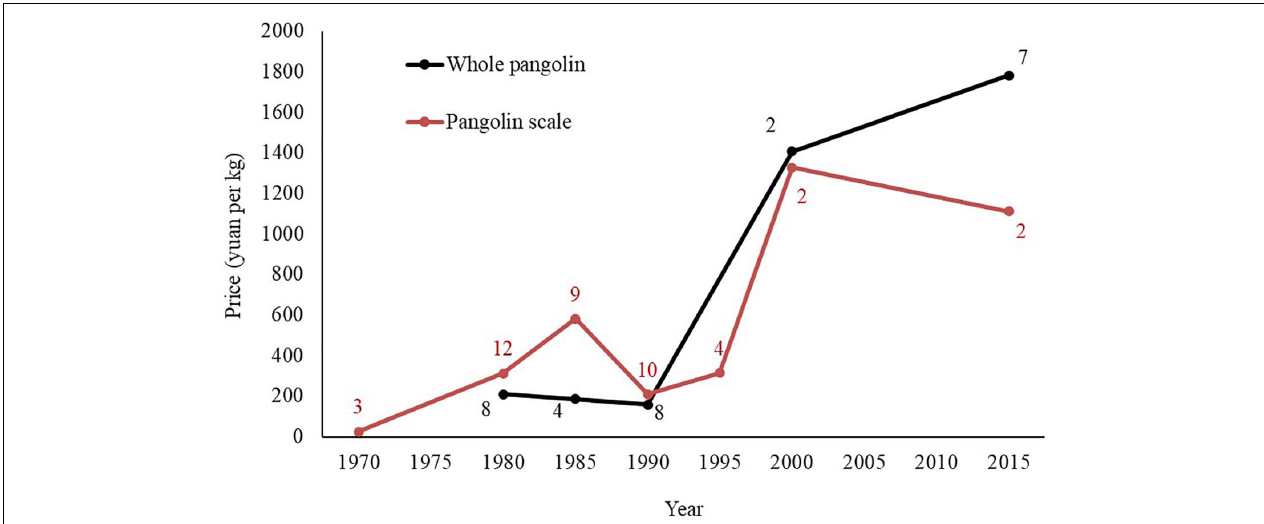
FIGURE 4 | Historical price of whole pangolins (black line) or pangolin scales (red line) reported by interviewees. Data are grouped into 5-year time bins, indicated on the x axis by the first year of each respective time bin. Mean reported prices are given for each time bin; numbers associated with each data point show the number of prices reported for that